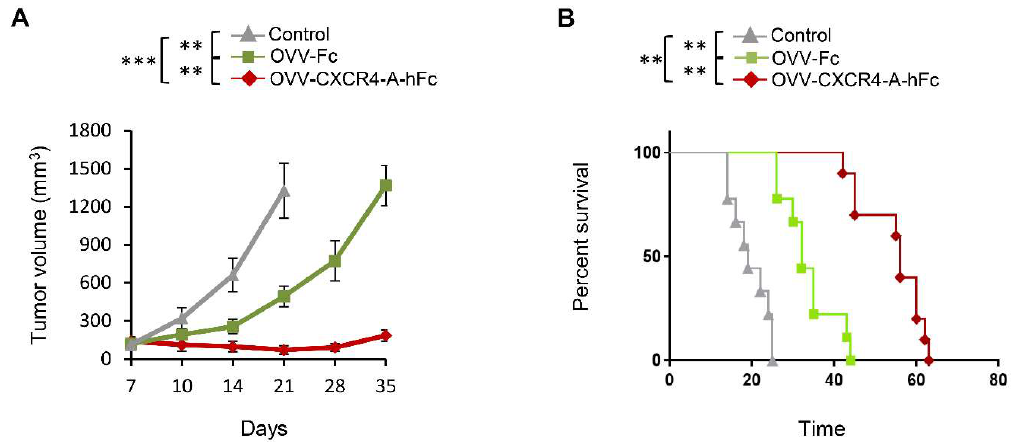
Figure 4. The efficacy of the NXS2 tumor lysate-loaded therapeutic DC vaccines is augmented by OVV-CXCR4-A-Fc treatment. A/J mice (n = 5/group) were challenged with 2 × 10 6 NXS2 cells. The OVV-CXCR4-A-Fc treatment. A/J mice (n = 5/group) were challenged with 2